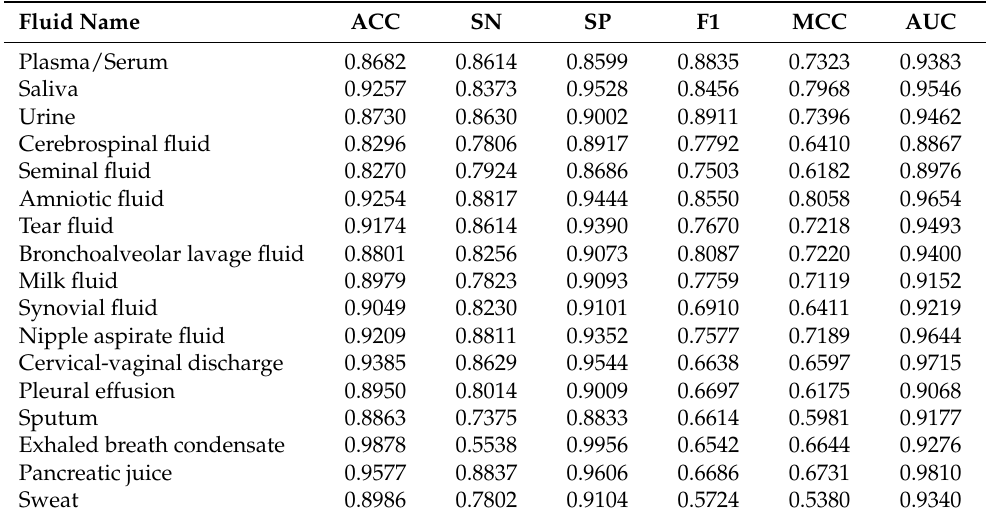
Table 2. Benchmarks of MultiSec on the independent testing datasets of 17 human body